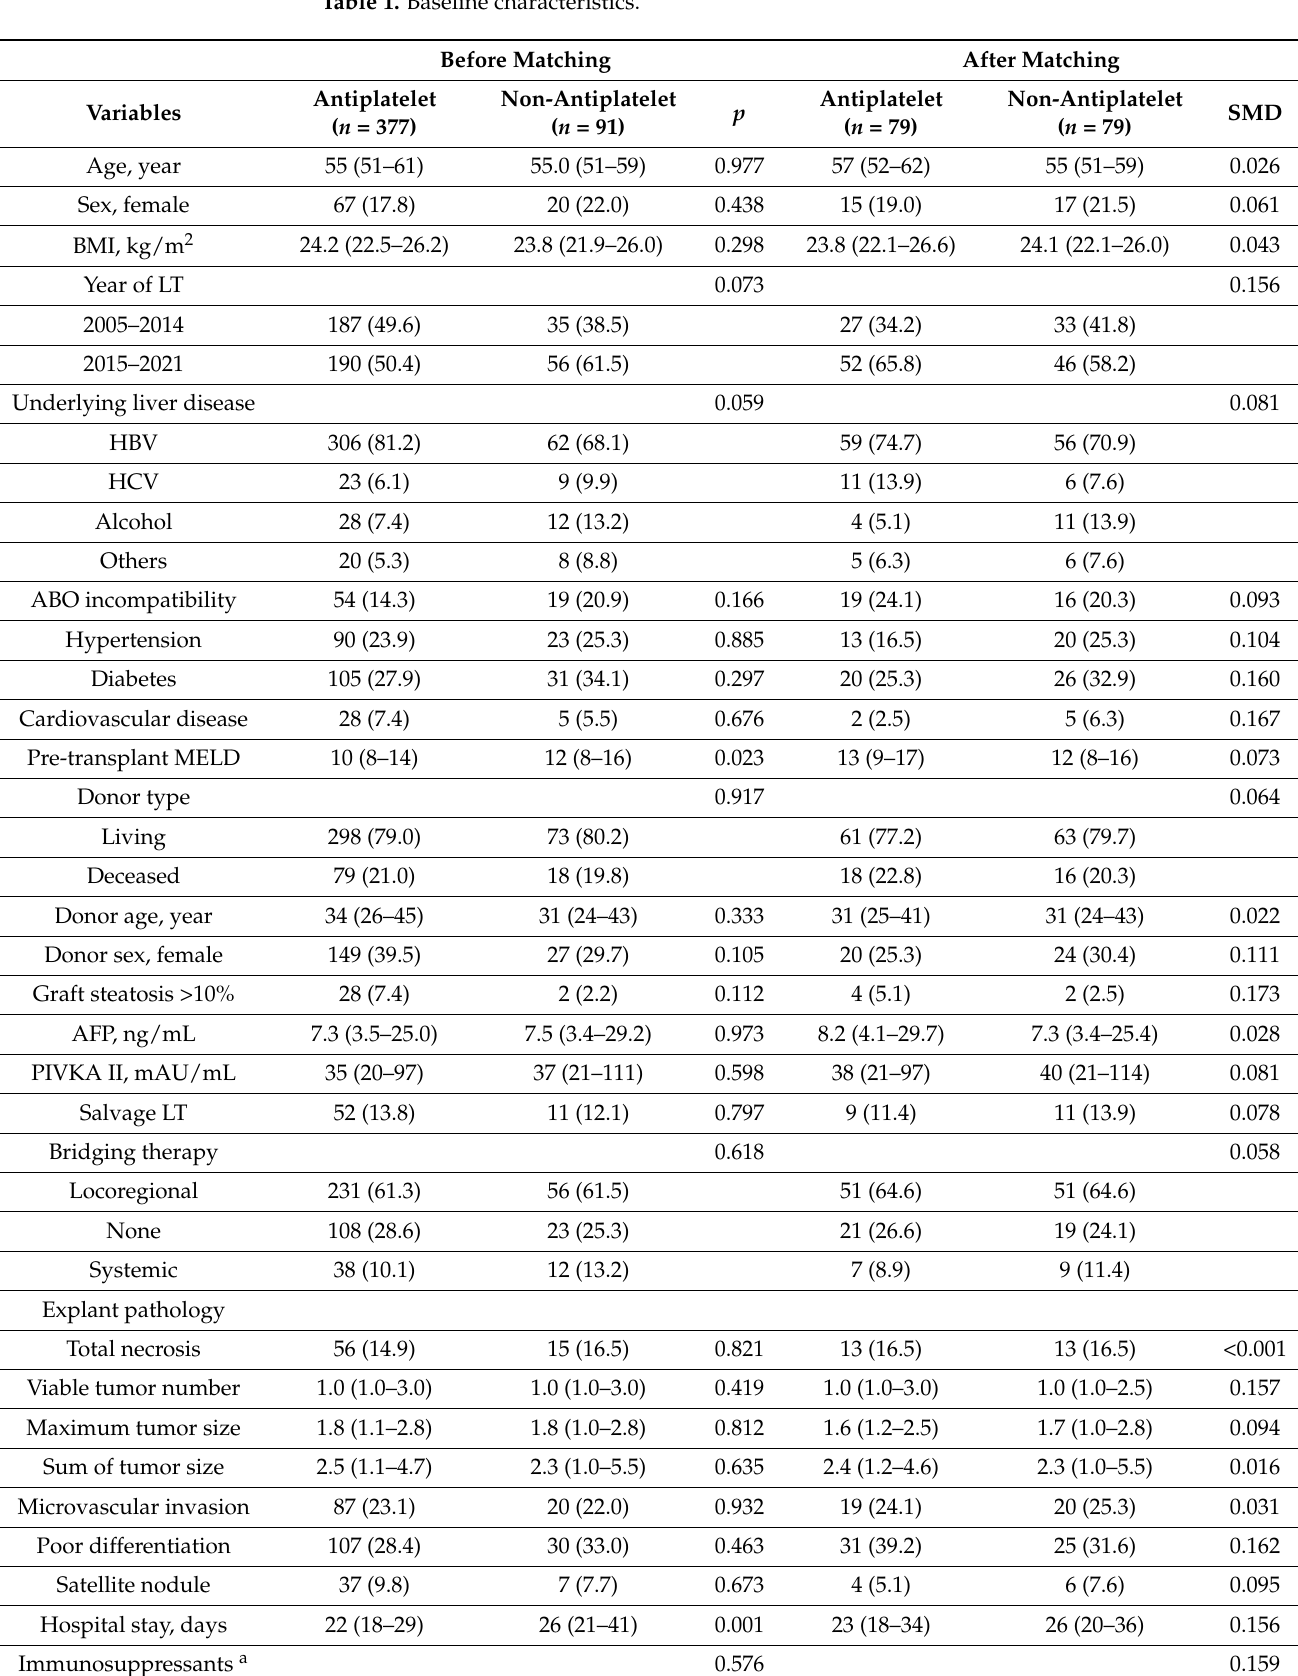
Table 1. Baseline